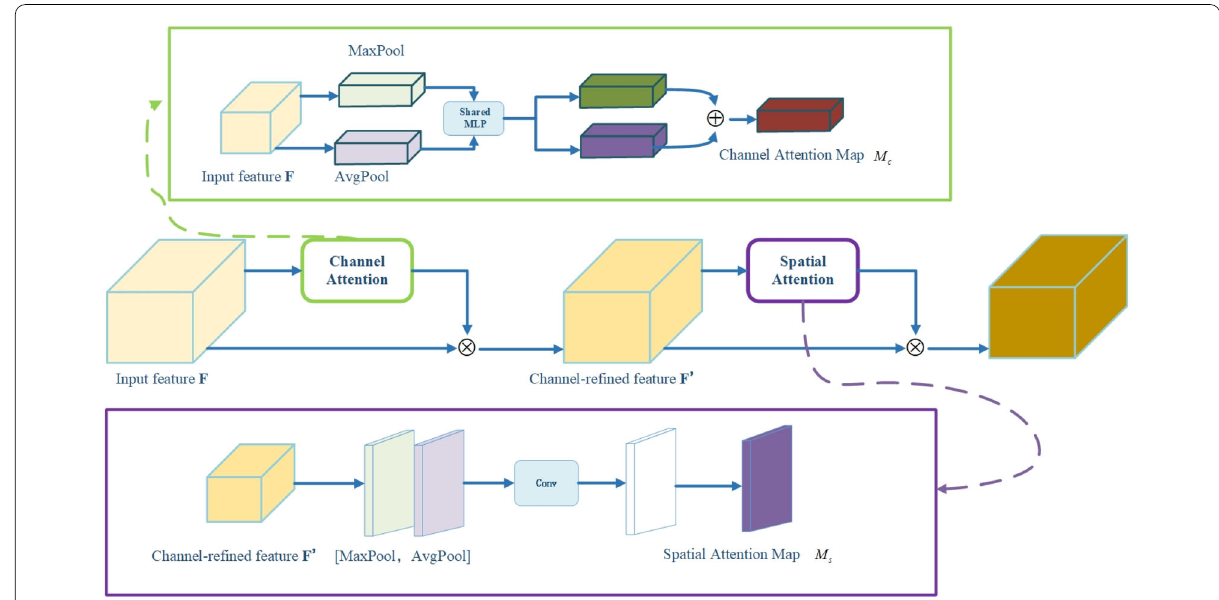
Figure 5 The structure of the CBAM